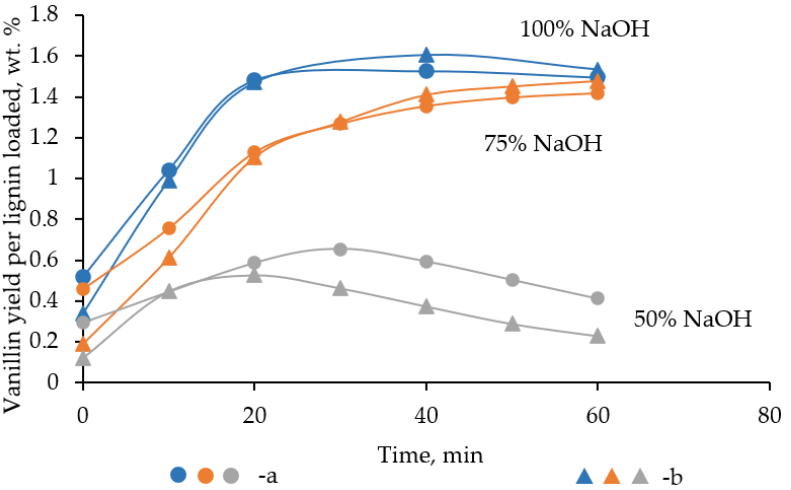
Figure 5. Dynamics of vanillin accumulation in the oxidation processes of the initial ( a ) and prehy- drolyzed ( b ) Belarusian flax shives at different concentrations of NaOH. For process conditions see Figure 2.